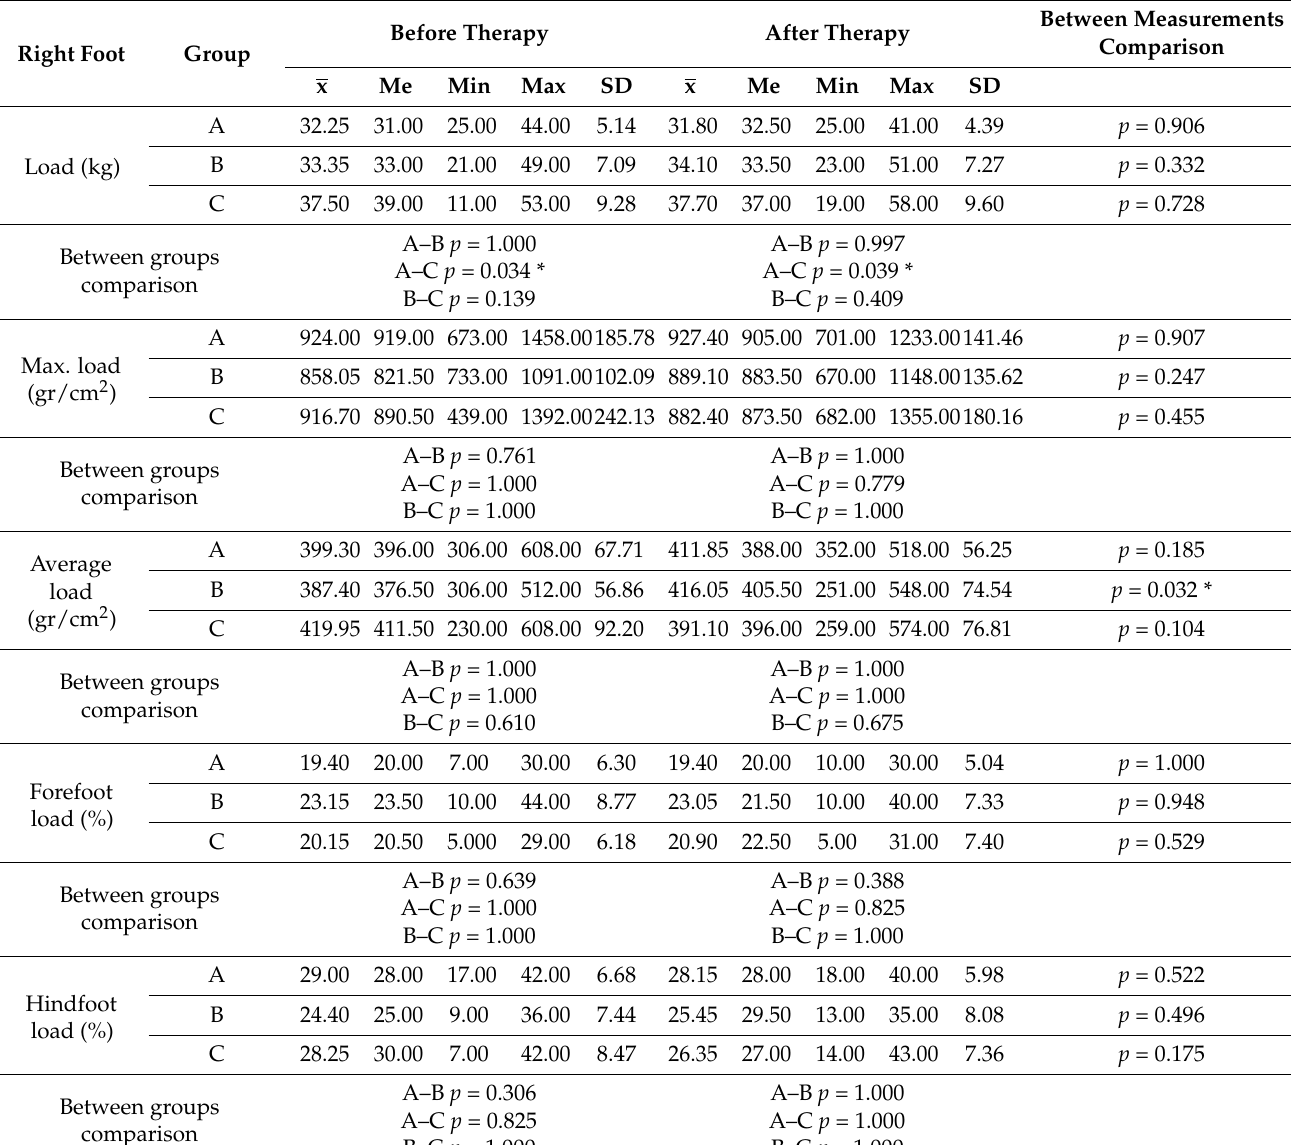
Table 3. Differences between selected right foot static indicators in the individual groups before and after therapy.